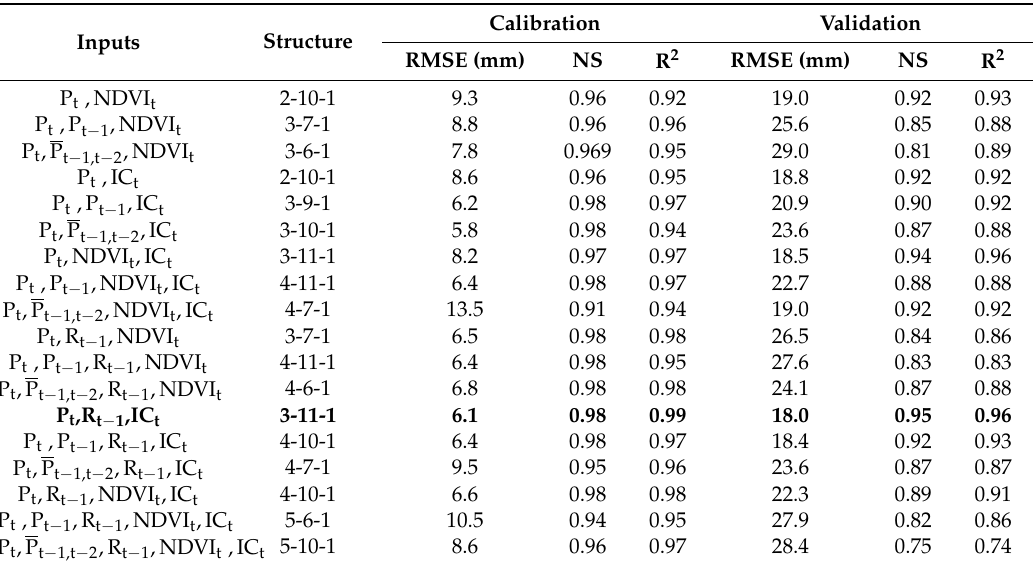
Table 6. Results of monthly time series modelling by ANN with different inputs during calibration and validation in the Calliope River